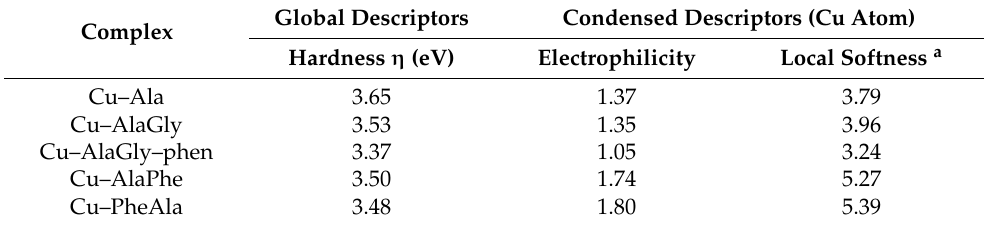
Table 4. Reactivity descriptors. The complexes are ordered from high to low in terms of